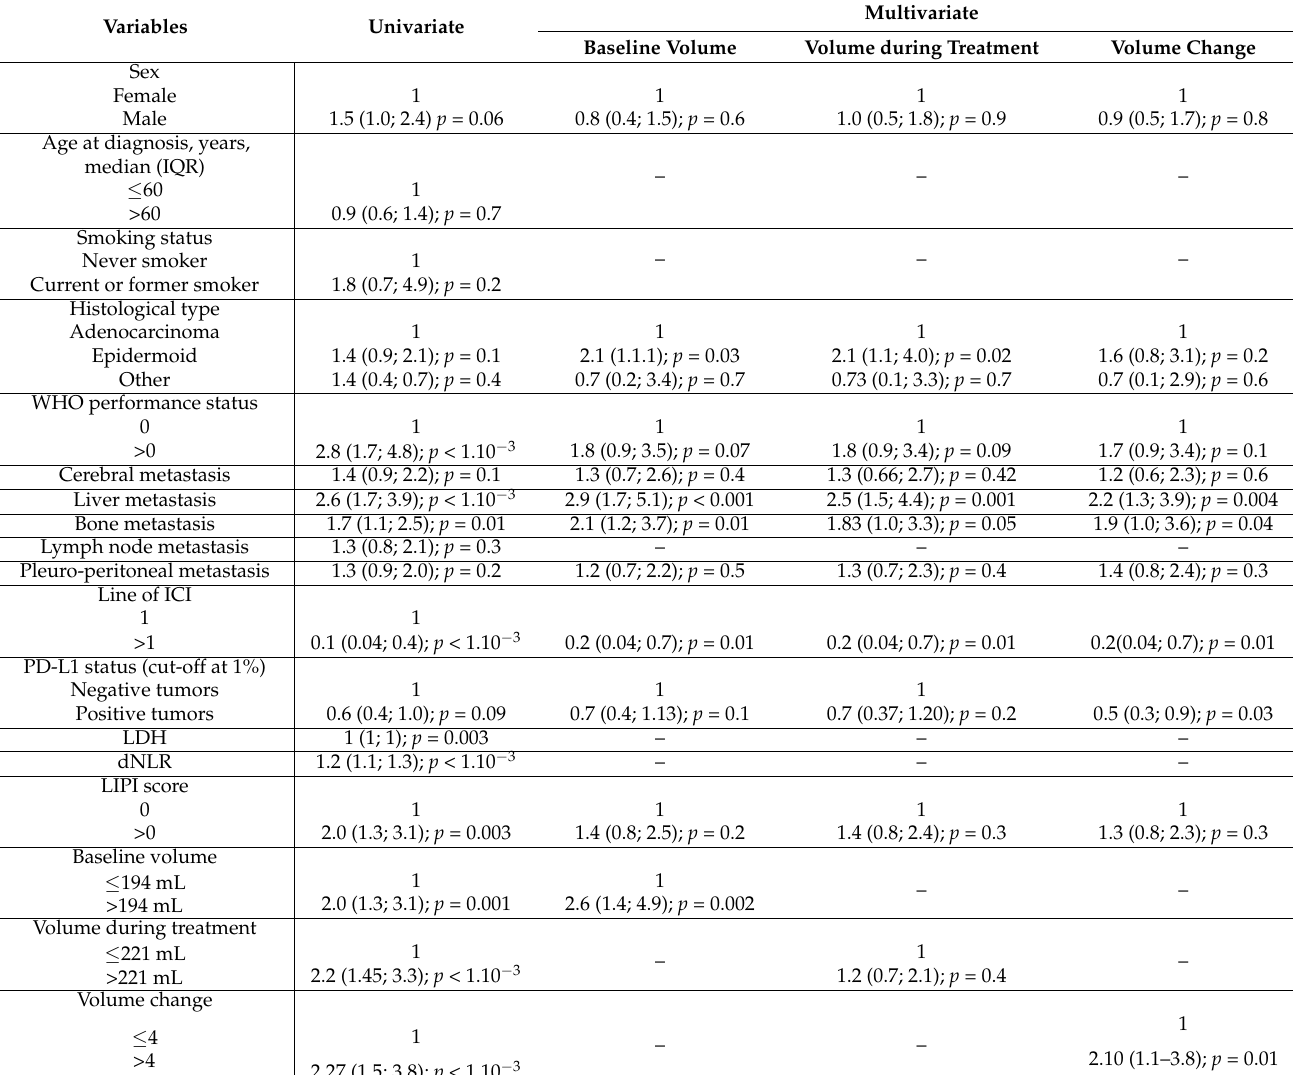
Table 2. Univariate and multivariate Cox models for overall survival (OS). Three multivariates were estimated, each involving either baseline volume, volume during treatment, or volume